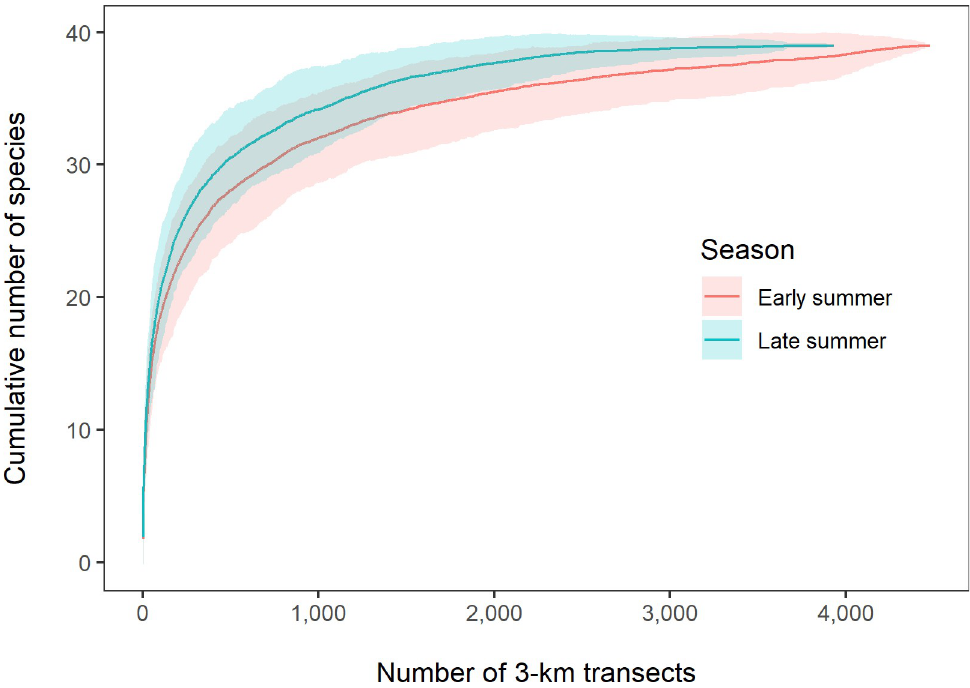
Fig 5. Seabird species rarefaction curves from surveys conducted in the northeastern Chukchi Sea in early and late summer, 2008–2018. Early summer (pink) was 13 August–6 September and late summer (aqua) was 7 September–2 October. Shading indicates 95% confidence intervals based on resampling transects without